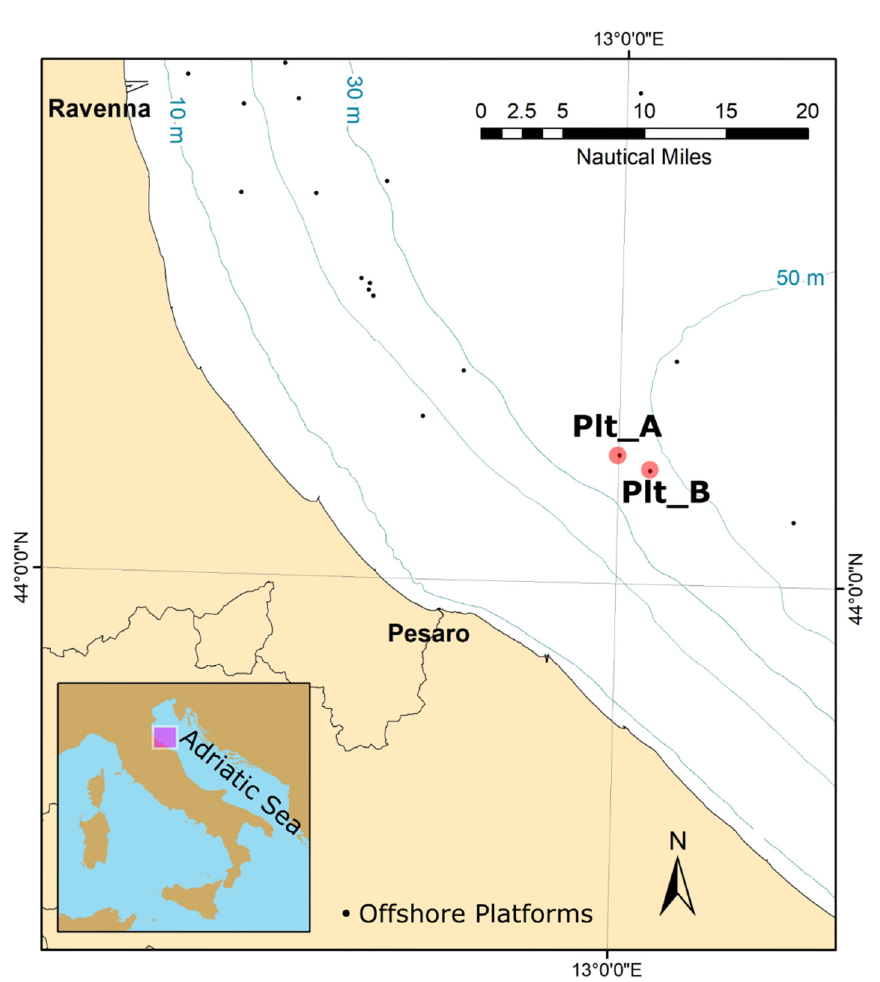
Figure 1. Adriatic Sea basin (blue line box), location of study area (violet box) and platforms site.